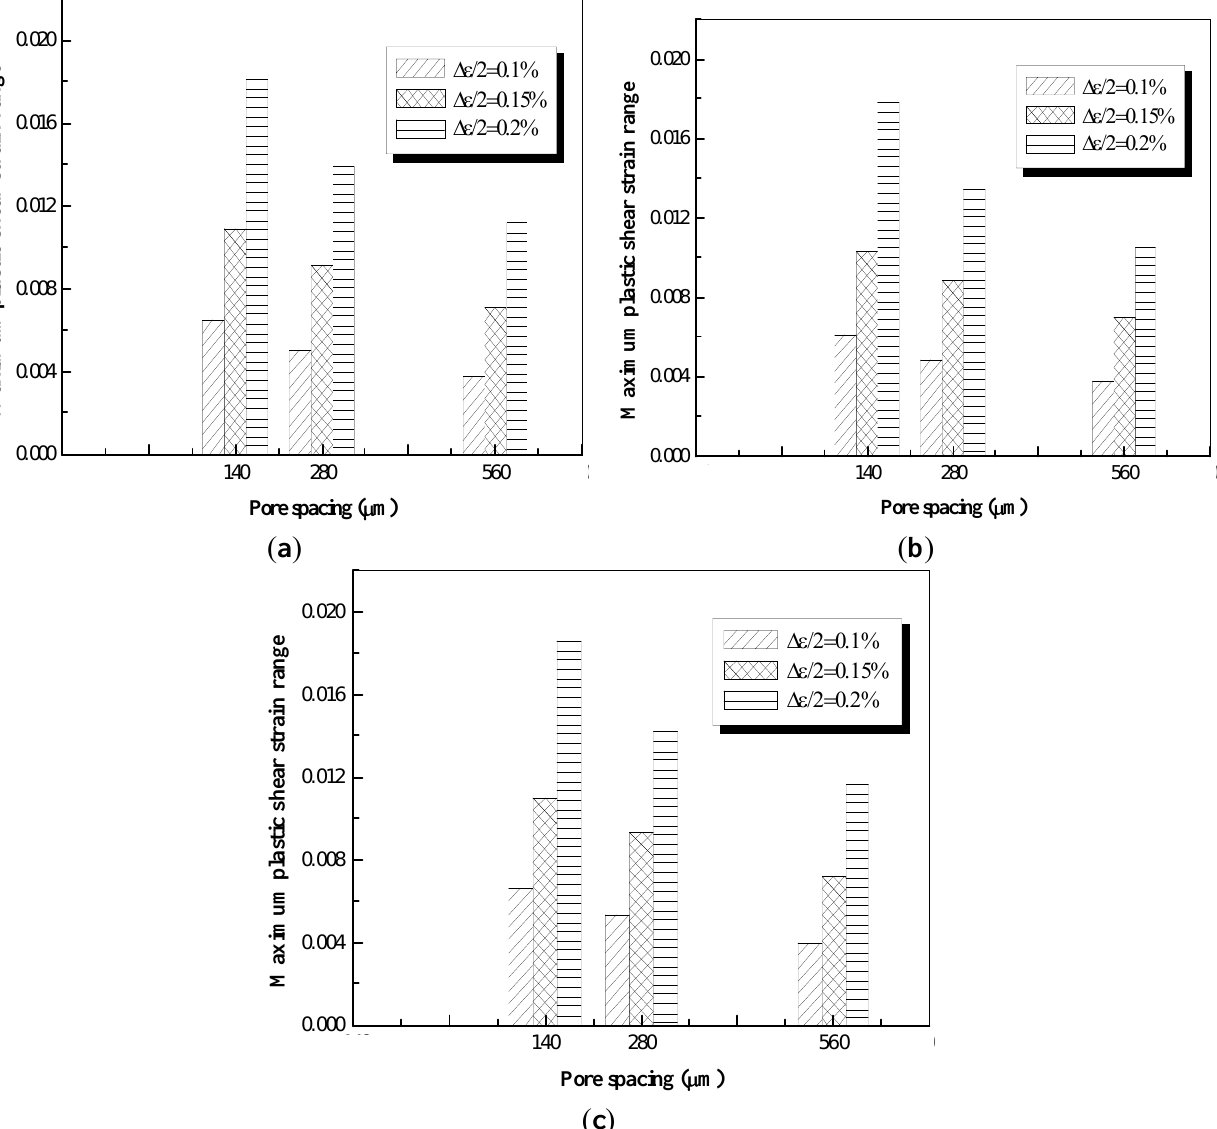
Figure 19. Pore spacing effect on the average maximum shear strain under the